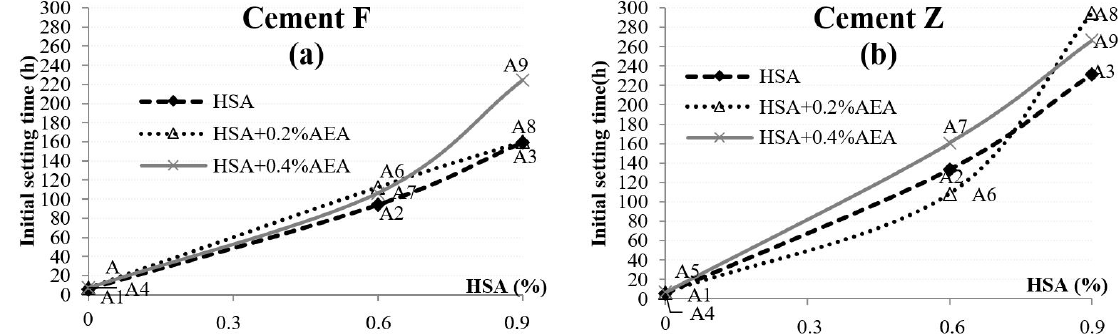
Figure 14. Effect of the increase in the content of HSA at the initial setting time of the